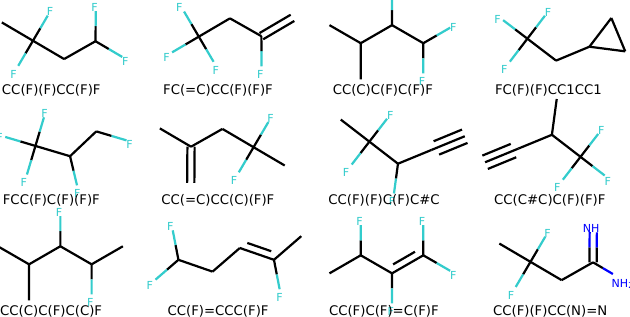
Figure 7. Molecules similar in latent space using the can2enum model. The reference molecule is in the upper left corner and similarity drops row-wise in normal reading